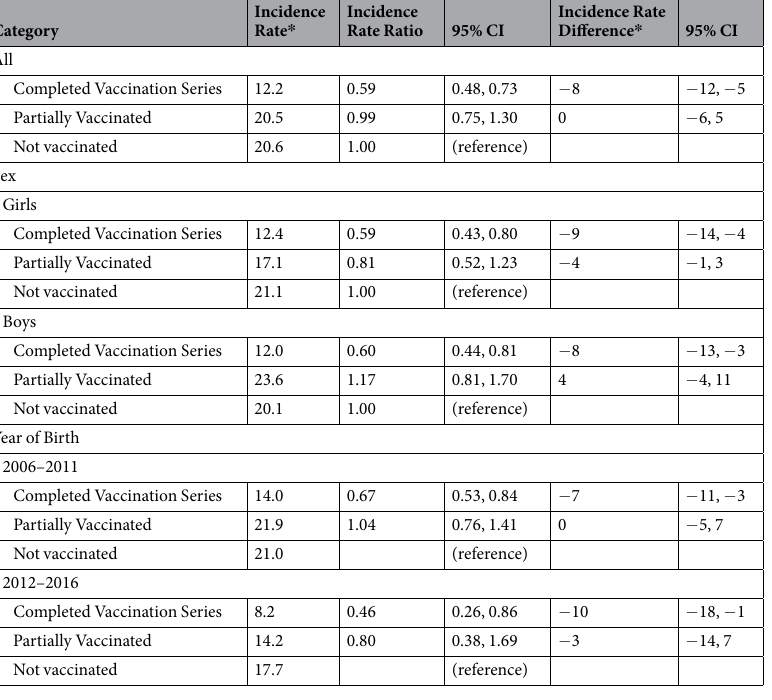
Table 2. Incidence Rate Ratio and Difference for Type 1 Diabetes, comparing Rotavirus Vaccination with No Rotavirus Vaccination, 2006–2017. * Per 100,000